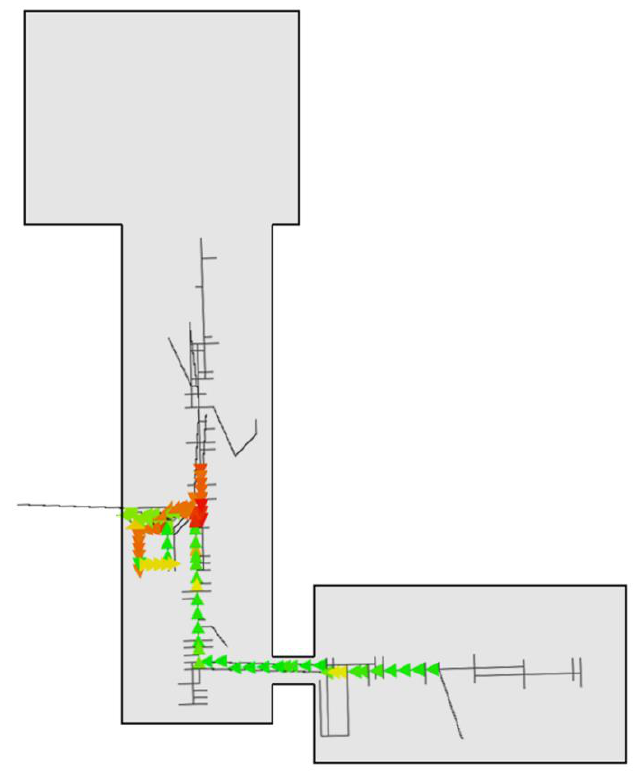
Figure 5. Visualization of the evacuation simulation Scenario 1 in its early progress after 40